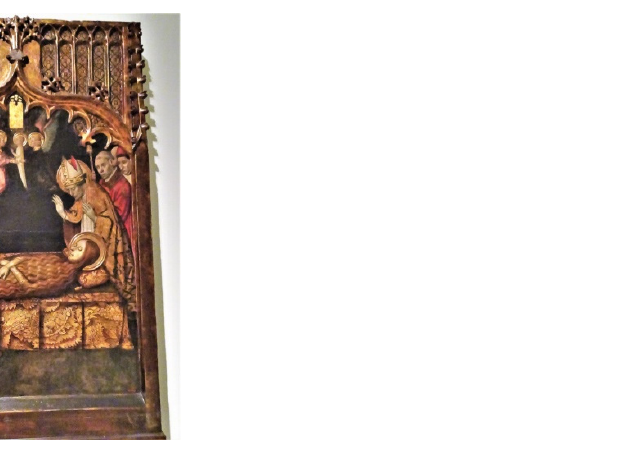
Figure 4. Jaume Huguet. “Death of Saint Mary Magdalene”. Detail from Altarpiece of Martyrdom of Saint Bartholomew; Calvary; Death of Saint Mary Magdalene , 1465–1480, Museu Nacional d’Art de Catalunya (MNAC).